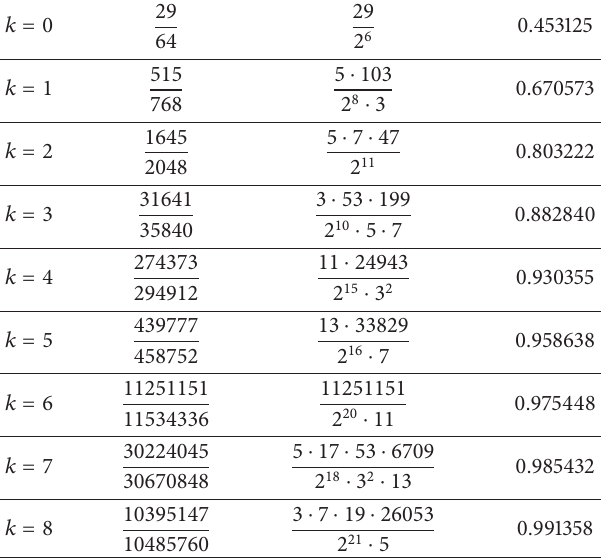
Table 1: Two-rebit ( 𝛼 = 1 / 2) separability